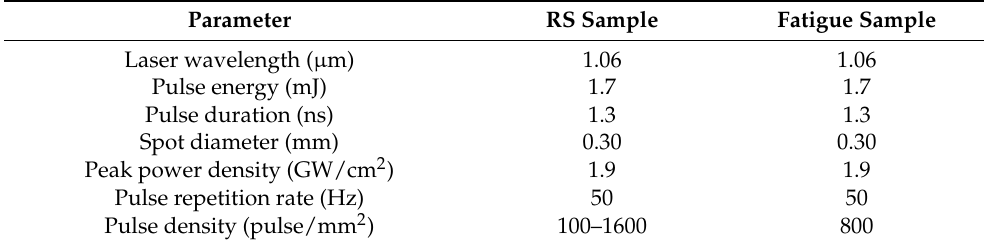
Table 3. The LPwC conditions.